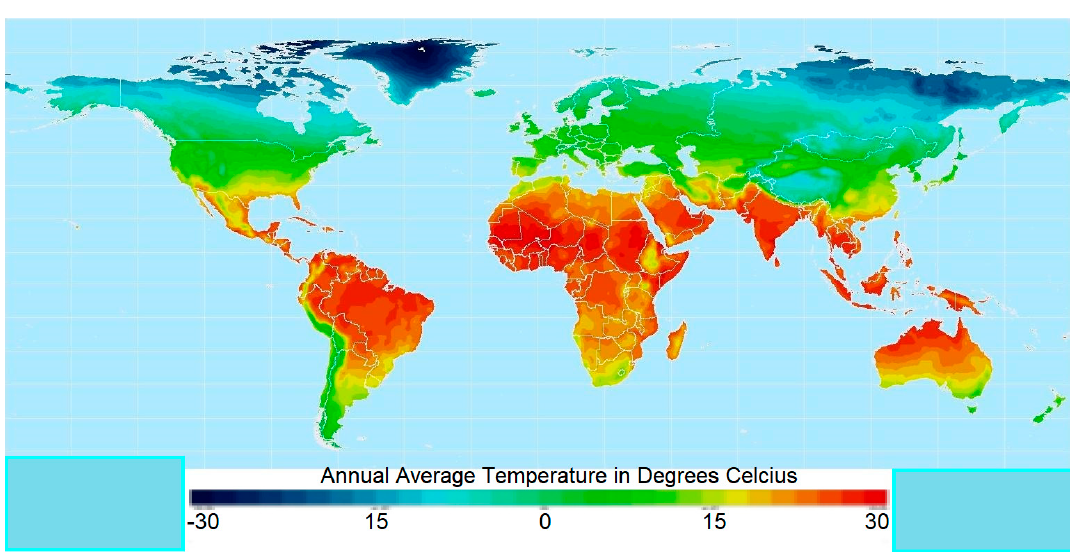
Figure 8. Annual average temperature (°C) of places on earth.